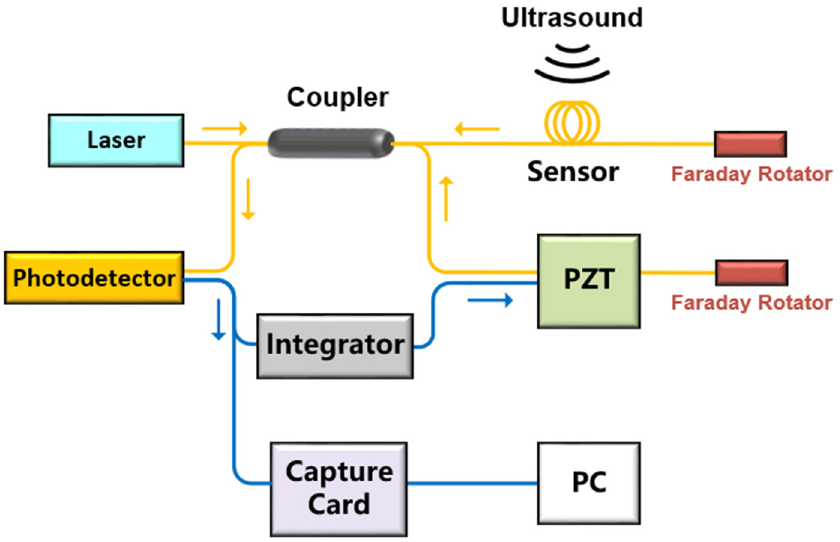
Figure 3. The structure of the interference ultrasonic sensing system with phase feedback control loop.